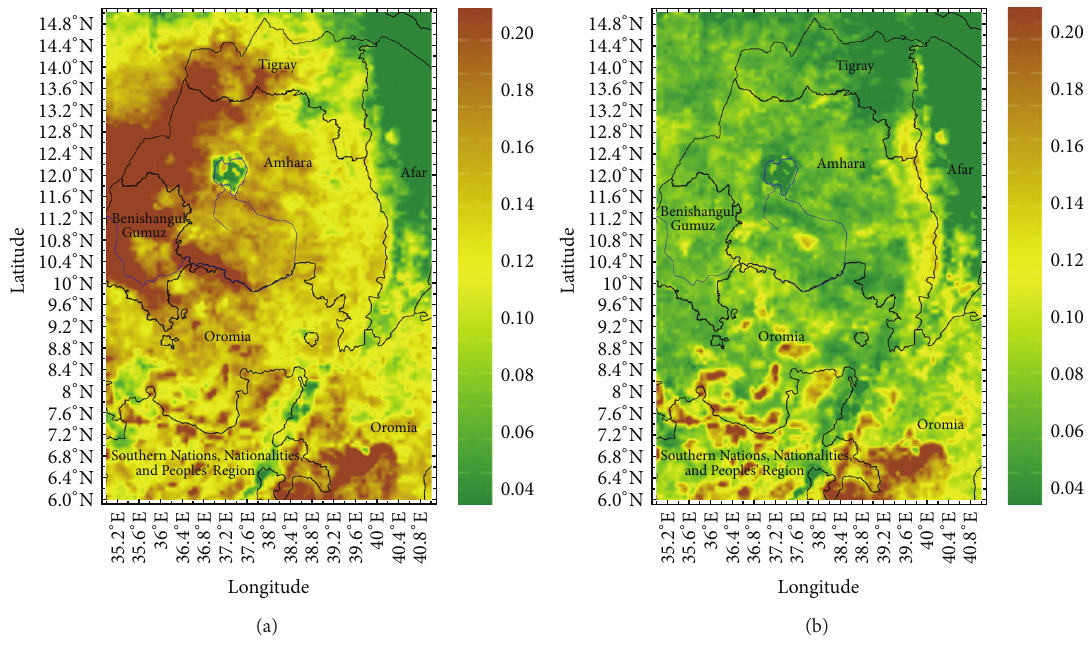
Figure 7: Standard deviation of (a) annual satellite NDVI and (b) interannual NDVI anomalies, showing areas vulnerable to fluctuations (brown) in the period 1981–2006. States borders/labels